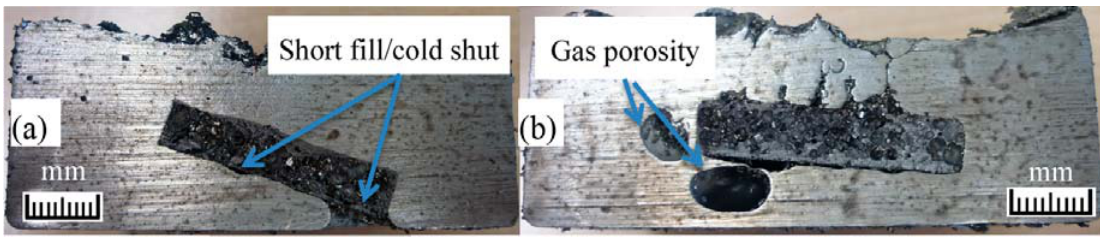
Figure 8. ( a ) Short fill and cold shut defects; and ( b ) gas porosity defects.